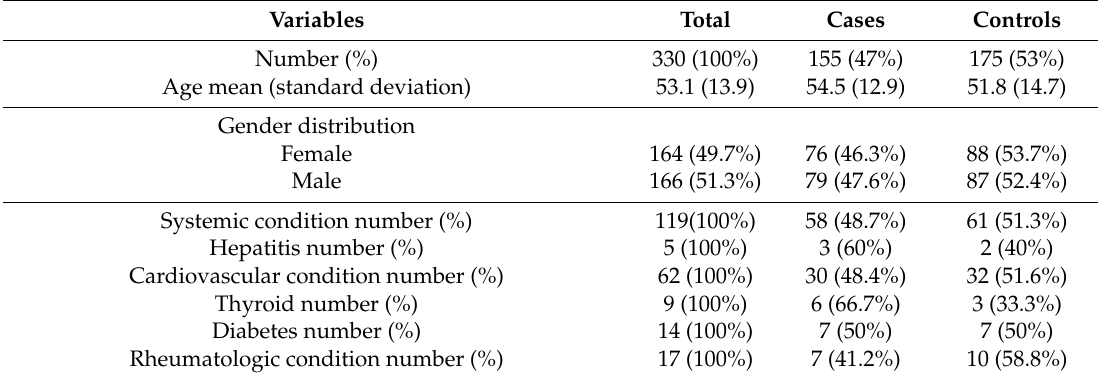
Table 1. Sample characteristics and distribution according to cases and